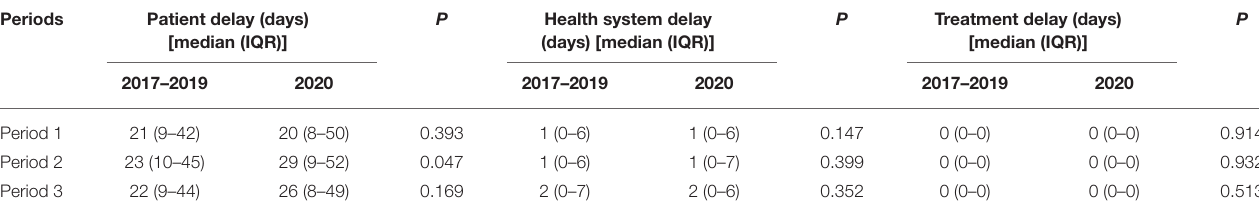
TABLE 3 | Comparison of patient delay, health system delay, and treatment delay breakdown by three periods between 2017–2019 and 2020.